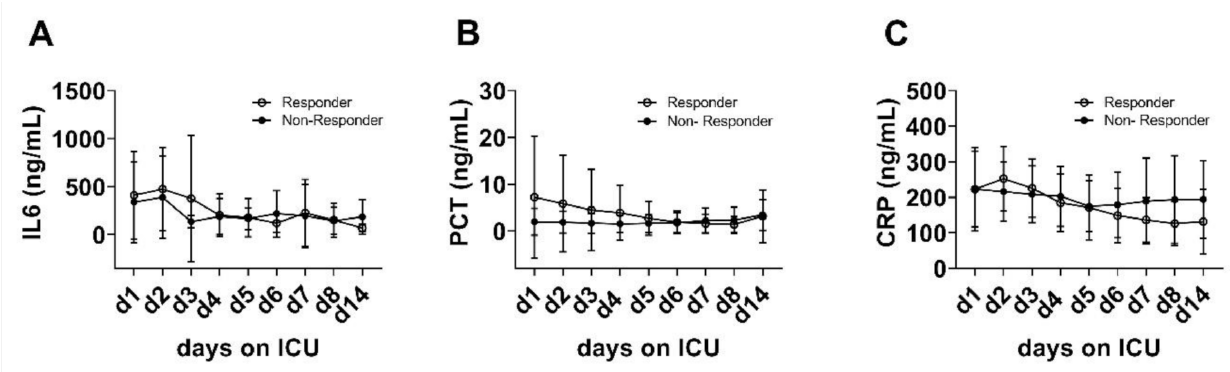
Figure 5. No changes of plasma interleukin 6 (IL-6) ( A ), procalcitonin (PCT) ( B ) and C-reactive protein (CRP) ( C ) from day 1 to day 14 were detected within or between the groups (IL-6: p = 0.587; PCT: p = 0.228; CRP: p =